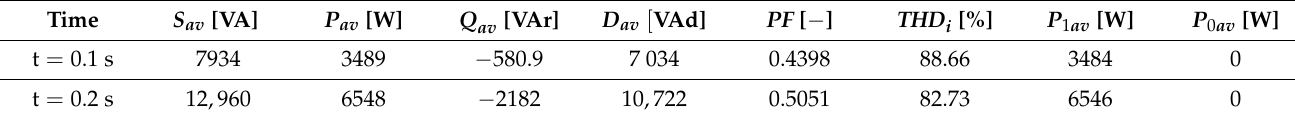
24. Table 24. Simulation results before and after the change (at steady states). Table 24. Simulation results before and after the change (at steady states).